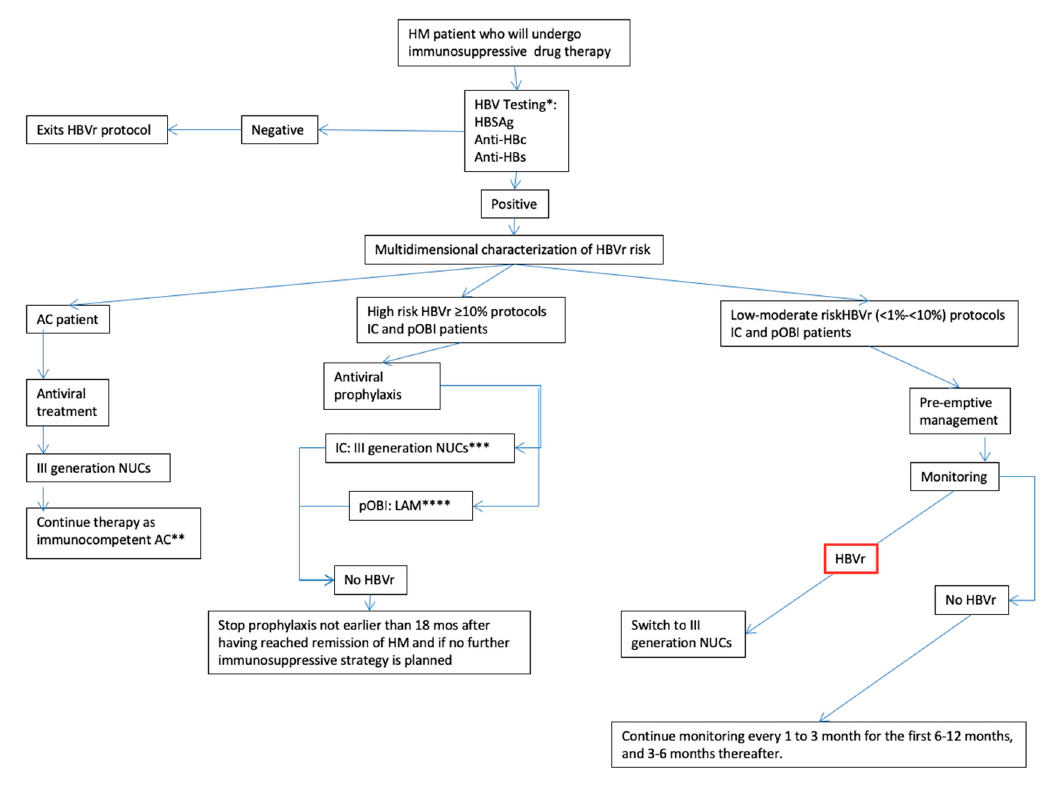
Figure 1. HBV-related reactivation risk: Simplified algorithm for the management of patients who will undergo immunosuppressive treatment for HM. *: Followed by sensitive HBVDNA testing if any of the previous returns positive. In case of patients only positive to anti-HBs, these should undergo accurate vaccinal medical history evaluation to define the need of HBVDNA testing. **: Might consider antiviral multidrug combo in case of partial virological contol. ***: In case of emergence of virological resistence and loss of control over viral replication, treat with alternative III generation NUC. **** : In case of emergence of viral resistence and loss of control over viral replication, switch to III generation NUC; III NUC: third generation anti-HBV nucleos(t)ide analogue; HBVr: Hepatitis B virus reactivation.